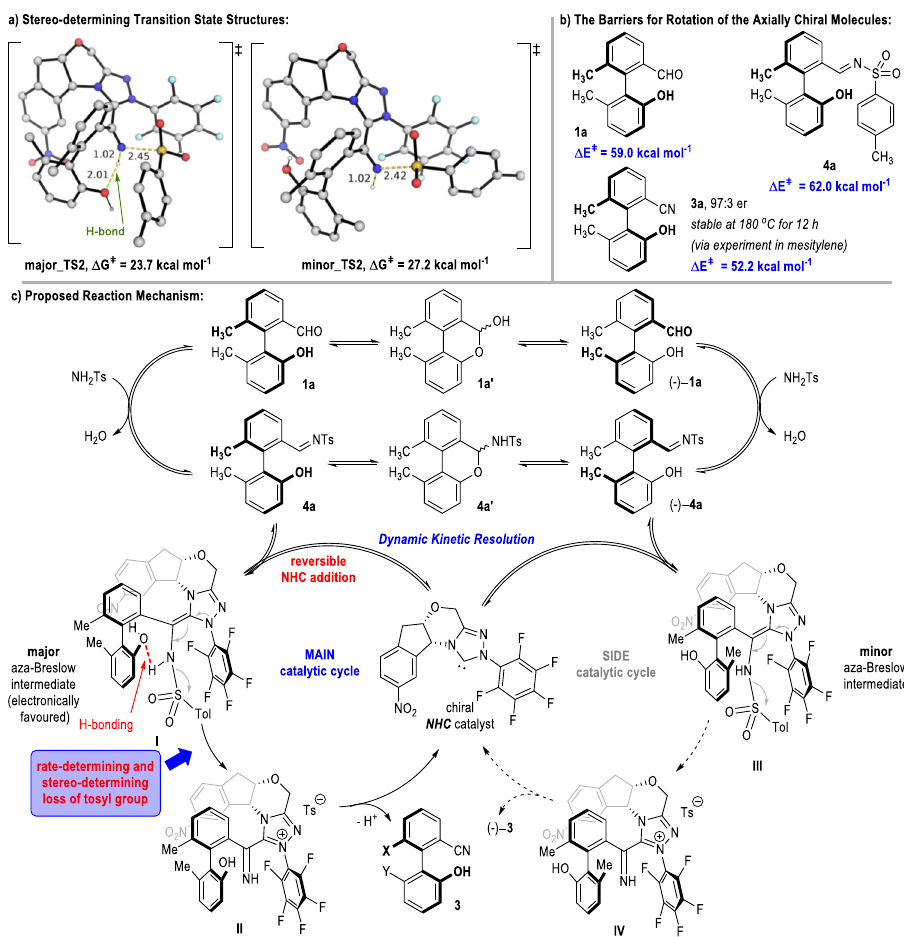
Fig. 3 Proposed reaction mechanism for the atroposelective synthesis of benzonitriles. a Stereo-determining transition state structures. b The barriers for rotation of the axially chiral molecules. c Proposed reaction